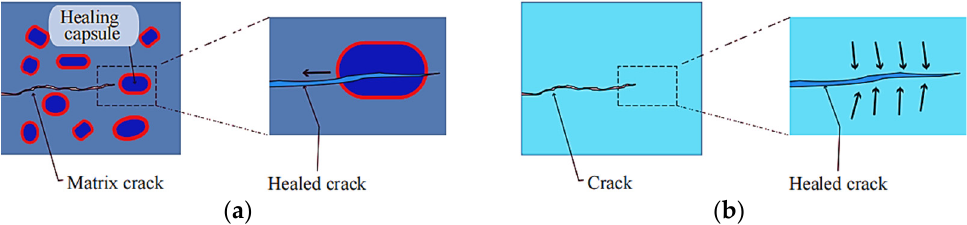
Figure 1. The material with one-time self-healing function ( a ) and multi-time self-healing function ( b ).